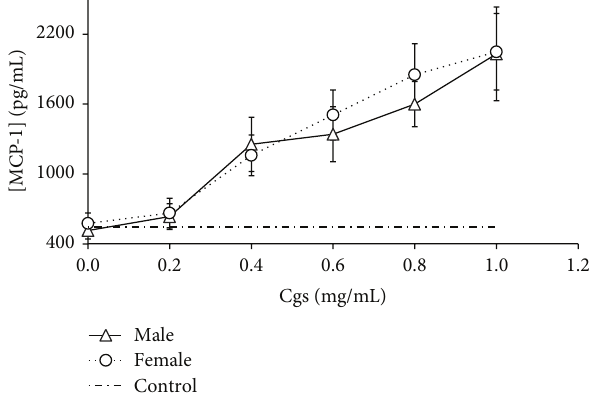
Figure 5: Increase in MCP-1 concentration (pg/mL) in culture medium after the 24-hour incubation of PBMCs from male and female healthy subjects with Cgs isolated from the blood of male and female SCZ patients,